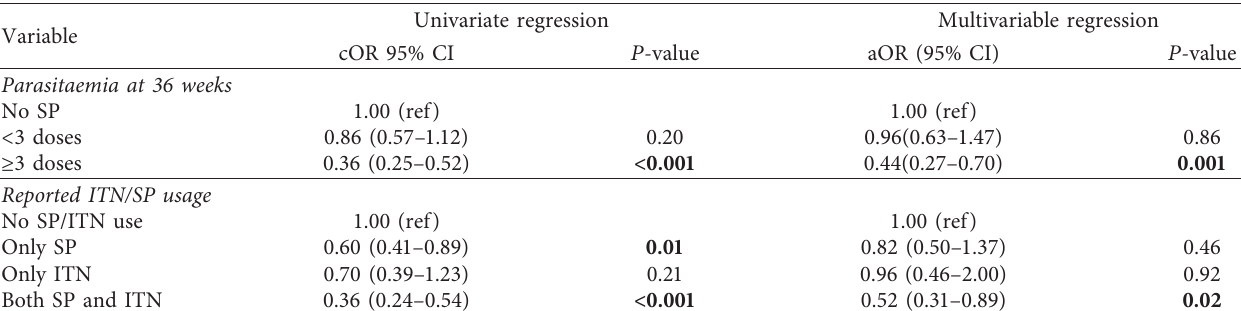
Table 4: Multivariable analysis between IPTp-SP and maternal parasitaemia at 36 weeks of